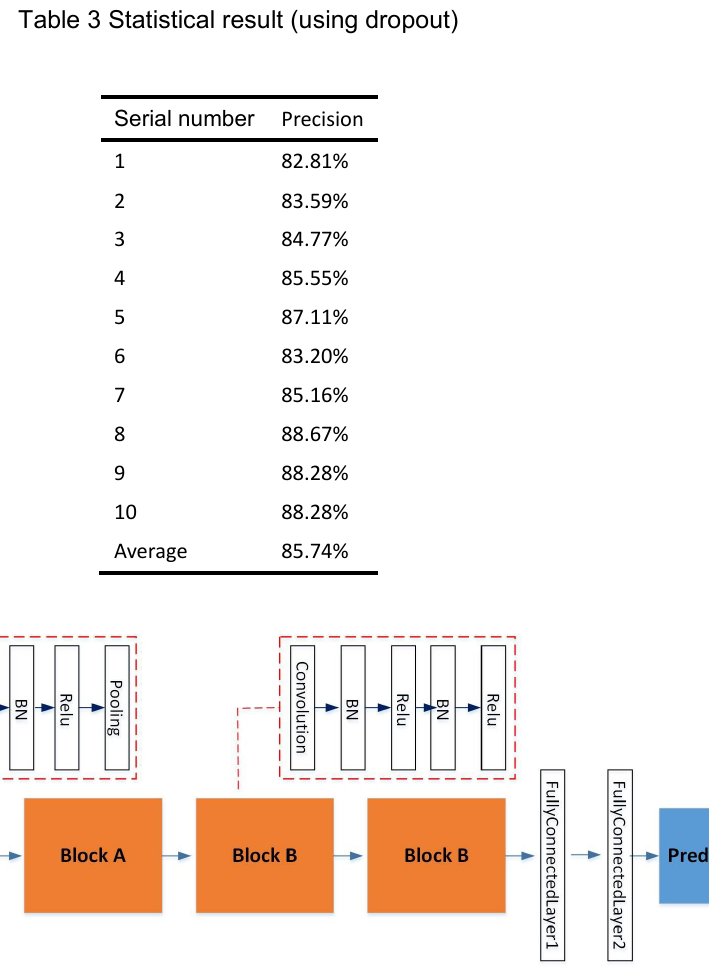
Figure 6. Our CNN network